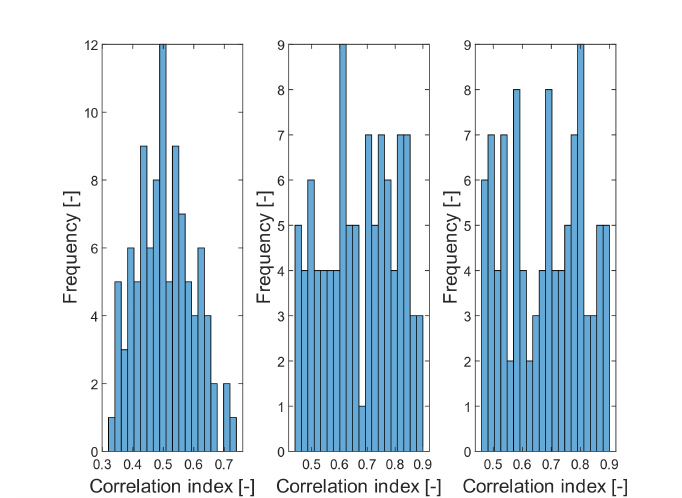
Figure 25. A comparison of distribution of correlation index for CT images, corrupted with Salt and Pepper noise with dynamic intensity: d = 0.01 − 0.65: Daubechies family ( left ), Symlet ( middle ) and Coiflet ( right ).